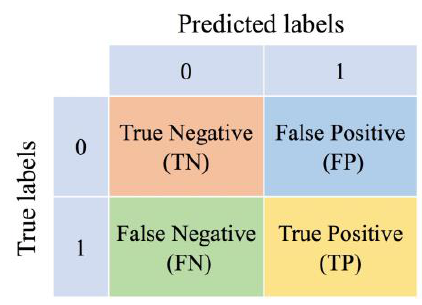
Figure 3. Illustration of the confusion matrix.